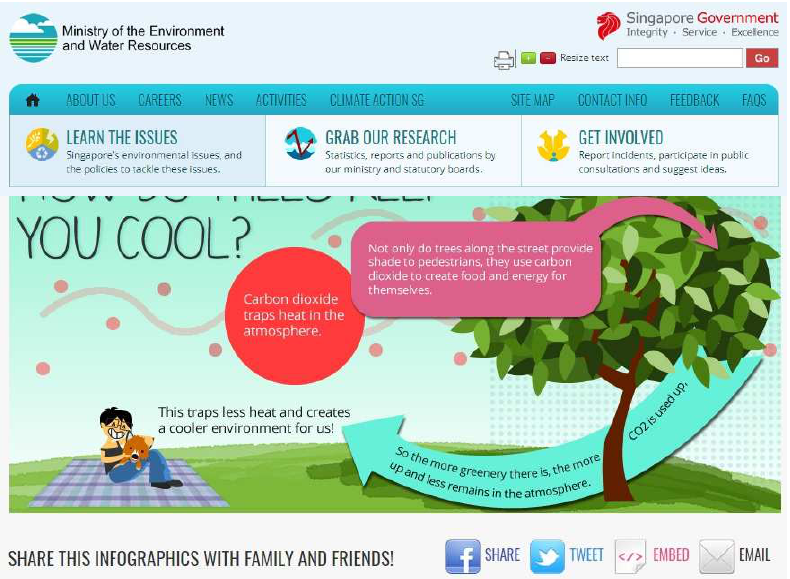
Figure 3. Official website of Singapore Government: Ministry of the Environment